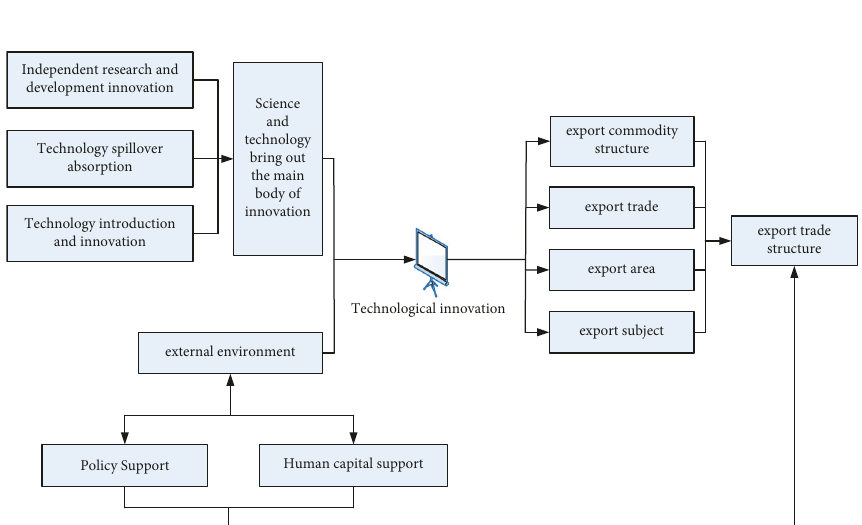
Figure 3: The influence mechanism of technological innovation on the structure of export trade.